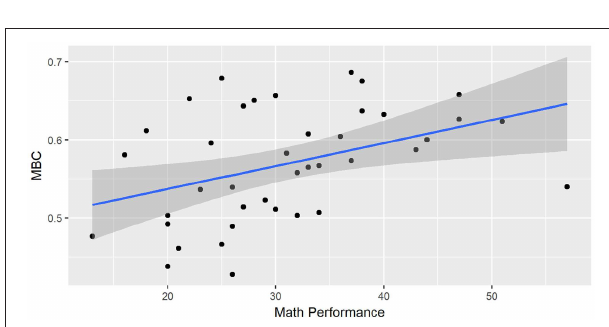
FIGURE 7 | Minimum Blocks Coefficient (MBC) by math performance (pre-test scores). We applied a linear model to data points with a 95% confidence level.